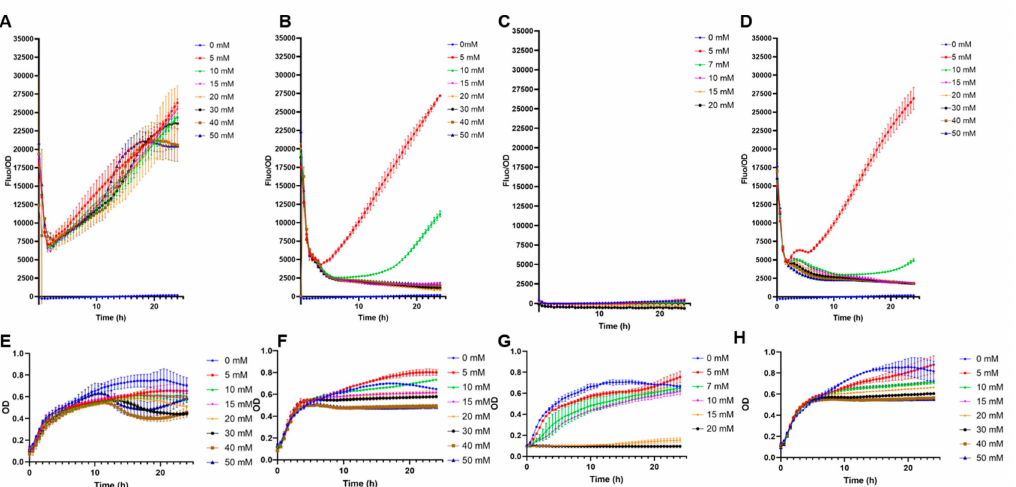
Figure 2. Specificity tests of E. coli BL21 containing pFuc_sfGFP_colE1. ( A ) F/OD rations in the presence of increasing concentrations of galactose; ( B ) glucose; ( C ) sialic acid; ( D ) mannose; ( E ) growth curves (OD values) of this strain in the presence of increasing concentrations of galactose; ( F ) glucose; ( G ) sialic acid; ( H ) mannose. Kinetics and growth curves were performed in triplicates and are presented as average ± SD.